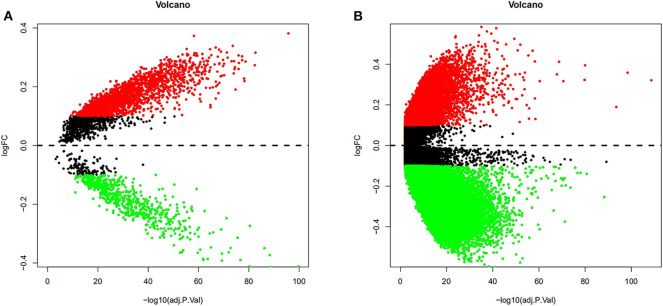
Volcano plots from the GEO and TCGA databases were conducted to depict the DMCs. Differentially methylated CpG sites from four GEO datasets were normalized, and the batch effects were removed. Among these 4,578 DMCs, only 3,737 DMCs were identified to significantly differ between tumor samples and adjacent normal tissues (A). After analysis of the TCGA LIHC cohort between tumor samples and adjacent normal tissues, a total of 200,000 DMCs were found (B). Values of P < 0.05 and log|FC| ≥ 0.1 were considered significant.